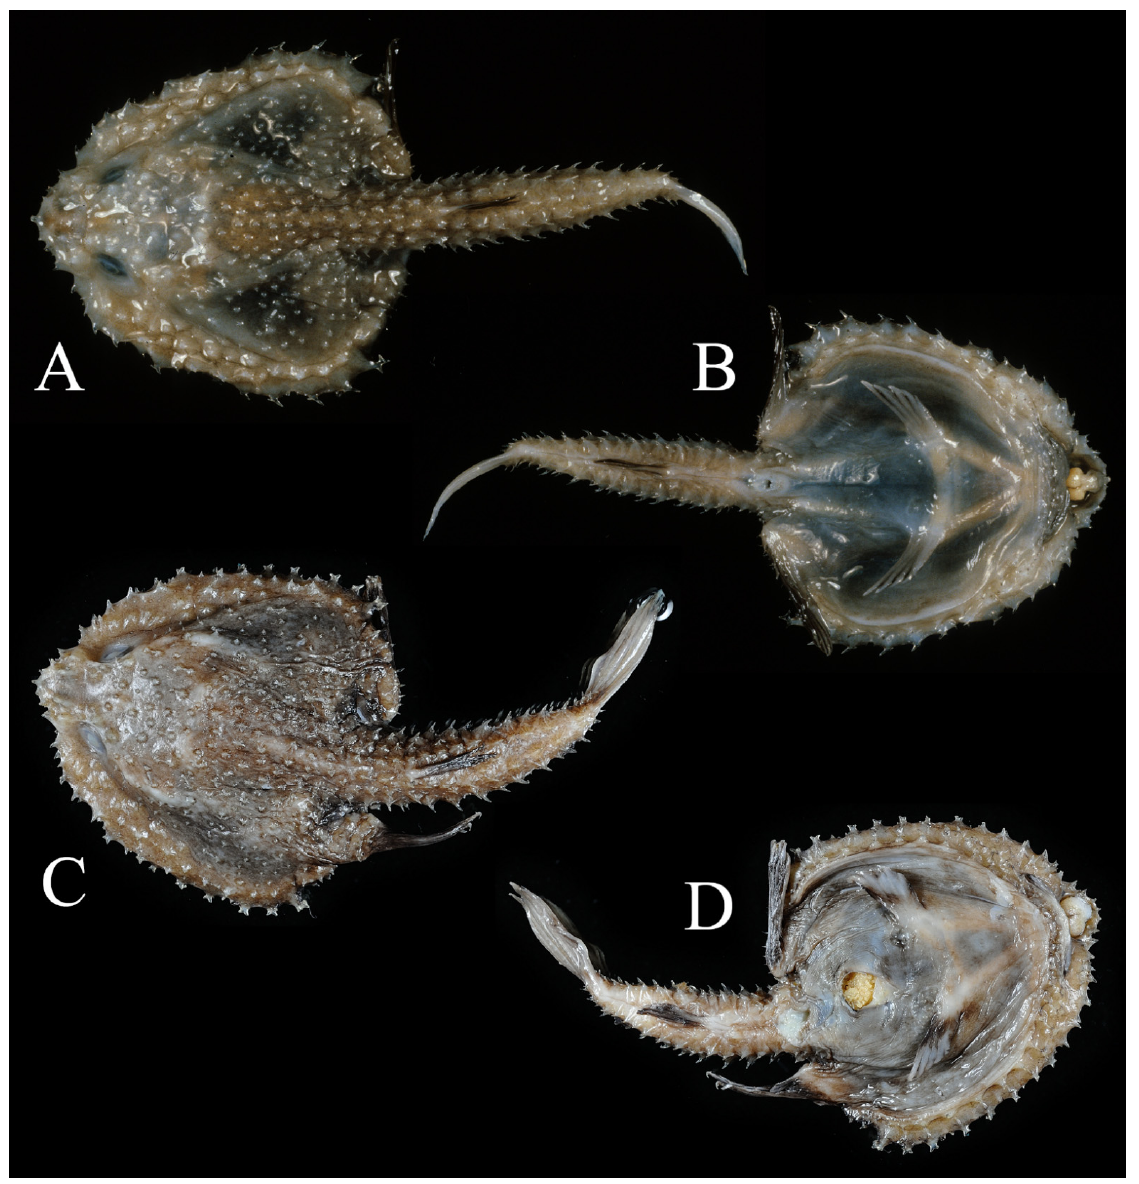
Figure 4. Halieutopsis bathyoreos Bradbury, 1988. ( A , B ). Holotype, SIO 84-43, 62.6 mm SL, Pacific Ocean, photos by M. G. Bradbury. ( C , D) . NSMT-P66375, 67.7 mm SL, Okinawa trough, photos courtesy of NSMT. ( A , C ). Dorsal view. ( B , D ). Ventral view.